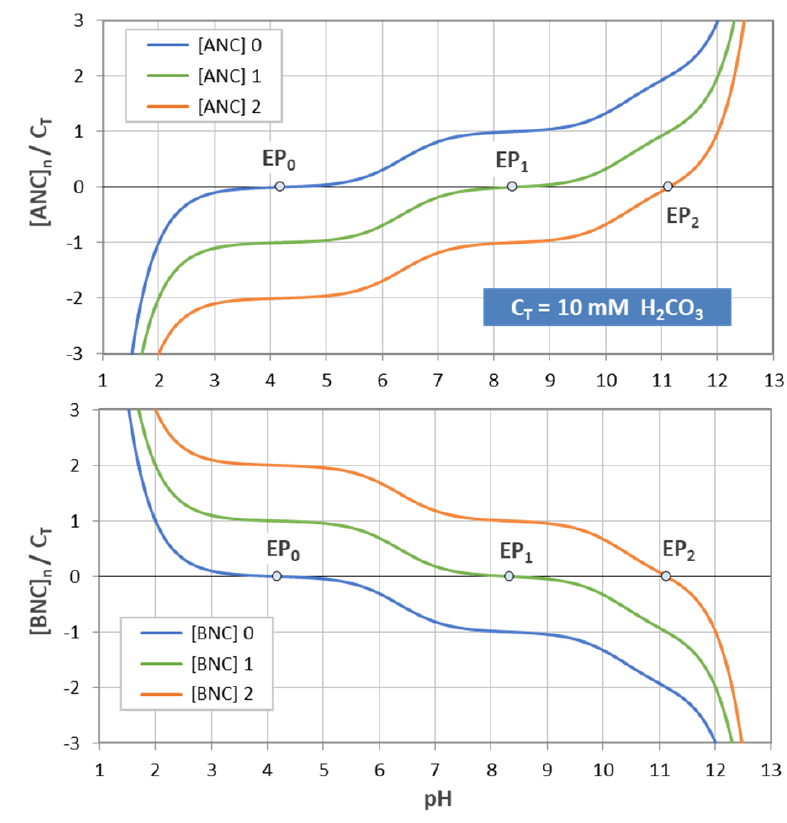
Figure 17. Normalized [ANC] n and [BNC] n for carbonic acid with C T = 10 mM.